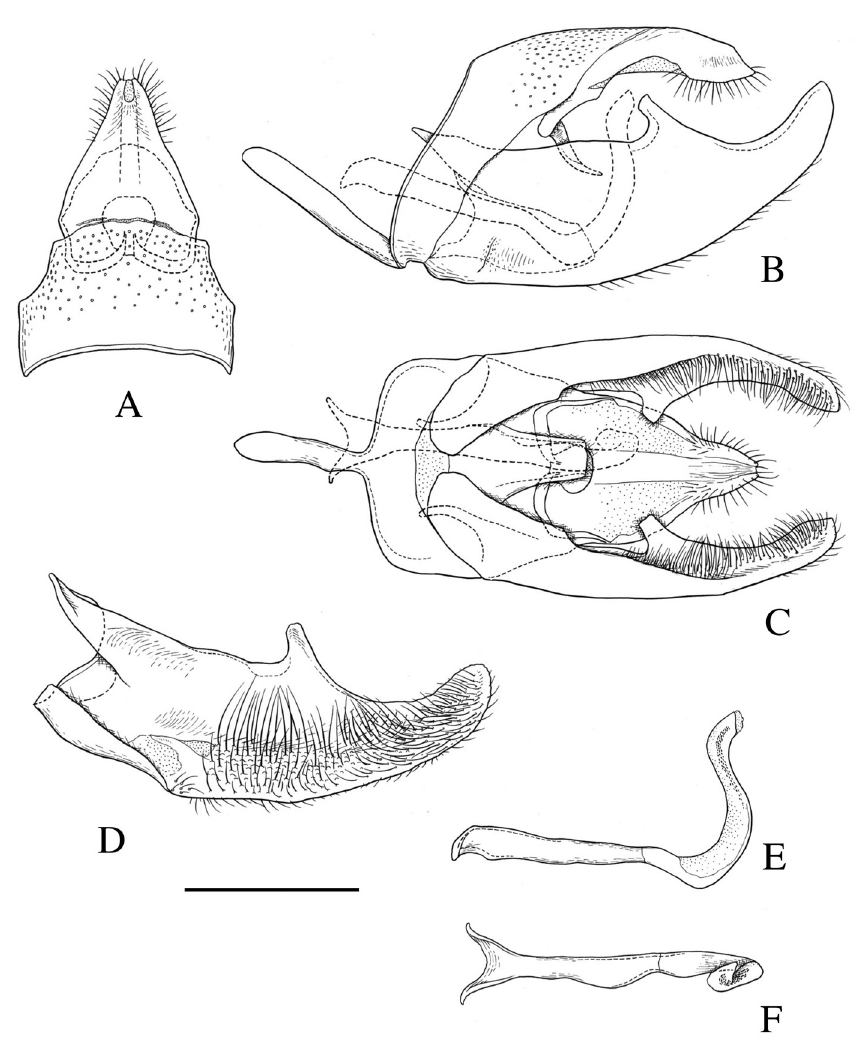
Figure 8. Male genitalia of Roeslerstammia tianpingshana sp. n., holotype. A Dorsum (uncus and tegu- men), dorsal view B genitalia without phallus, lateral view (basal long hair scales of valva removed) C Ditto ventral view D Right valva, inner view E Phallus, lateral view F Ditto , dorsal view. Scale bar 0.5